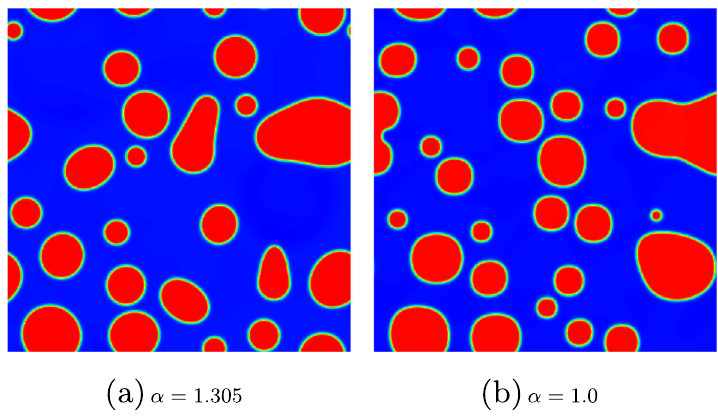
Fig. 14 Snapshots of the spinodal decomposition process, τ = 0.3 , T r = 0.8 , t =